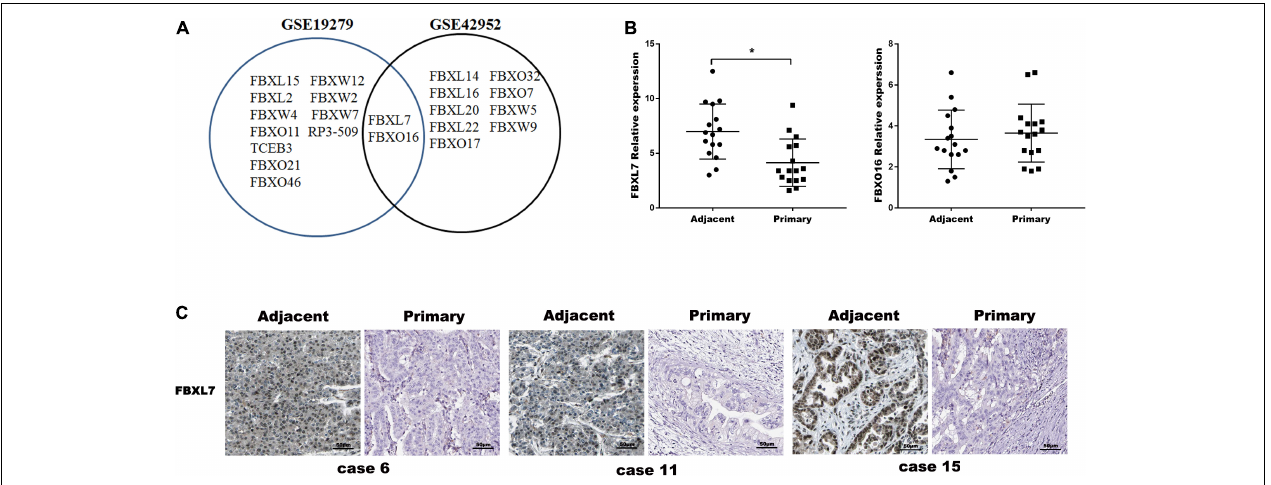
FIGURE 1 | FBXL7 expressions Clinic pathologic significance of PCa patients. (A) Venn diagram showing the intersections of F-box genes between GSE19279 and GSE42952. (B) Relative expression of FBXL7 and FBXO16 in 16 pairs PCa tissues ( n = 16) were detected by qRT-PCR. Data represent means ± SD of three independent experiments with significance determined by two-tailed Student’s t -test * P < 0.05. (C) Representative IHC staining showed positive expression of FBXL7 in adjacent tissues and negative expression of FBXL7 in tumor tissues ( n = 5).